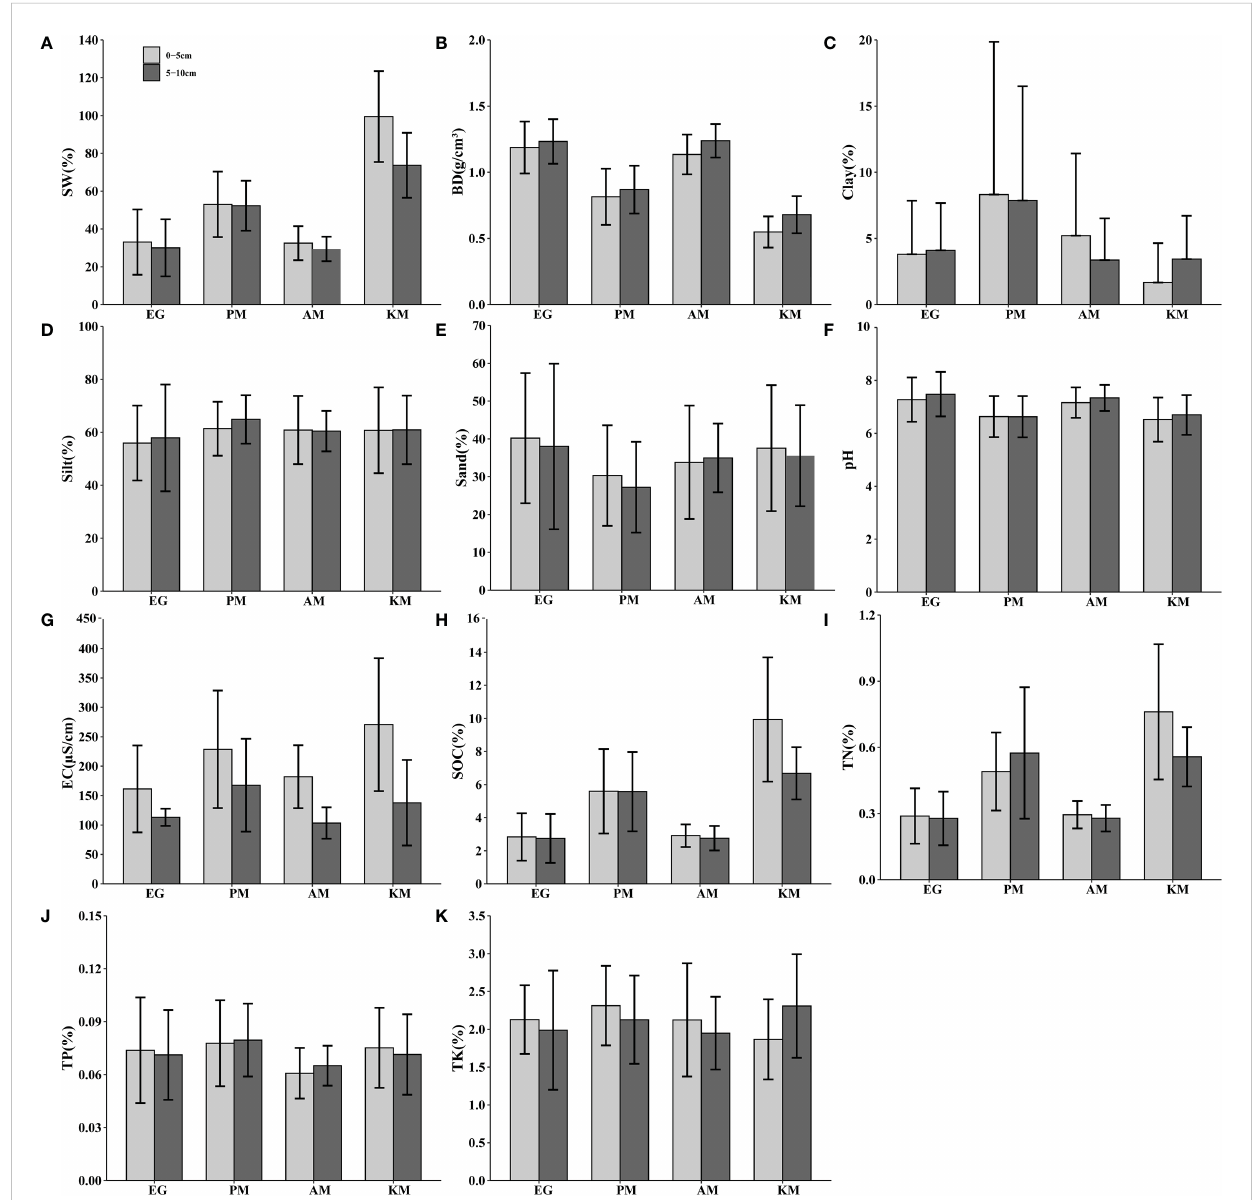
FIGURE 3 Soil physicochemical properties of plant communities in different alpine grasslands. Error bars indicate standard error. (A) SW(%), soil water content; (B) BD(g/cm 3 ), bulk density; (C) Clay(%), clay percentage; (D) Silt(%), silt percentage; (E) Sand(%),sand percentage; (F) pH, Potential of Hydrogen; (G) EC ( m S/cm), Electrical Conductivity; (H) SOC(%), Soil Organic Carbon; (I) TN(%), Total Nitrogen; (J) TP(%), Total Phosphorous; (K) TK(%), Total Potassium; EG, E.nutans -dominated grassland; PM, P.anserina -dominated meadow; AM, A.frigida -dominated meadow; KM, K.pygmea -dominated